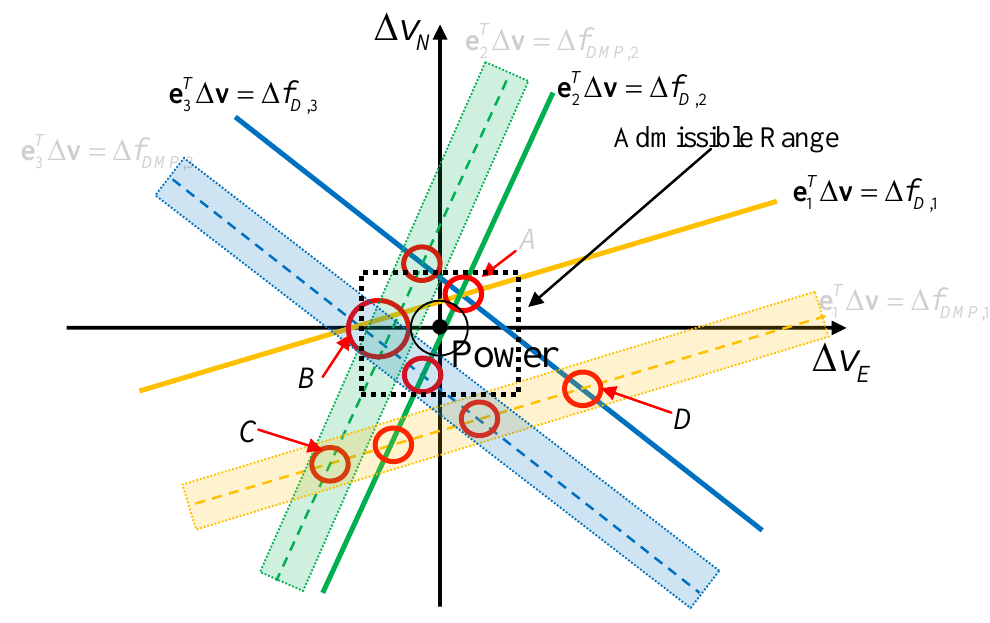
Figure 4. Velocity MLE with channel distortion (2D